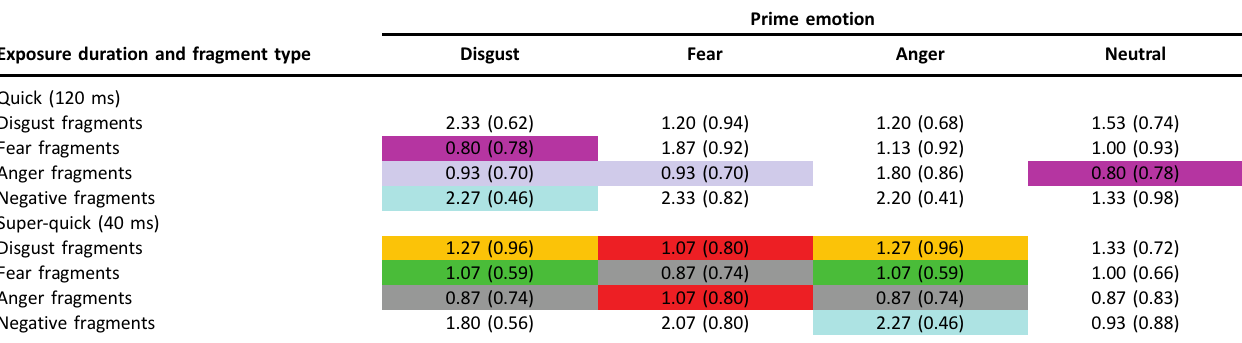
Table 3. Reproduction of Table 1 from the retracted Ruys and Stapel (2008) paper. The table shows 32 cells with “ M (SD), ” of which 15 are direct duplicates of one of the other cells. The original version with highlighted duplicates can be found at osf.io/89mcn.